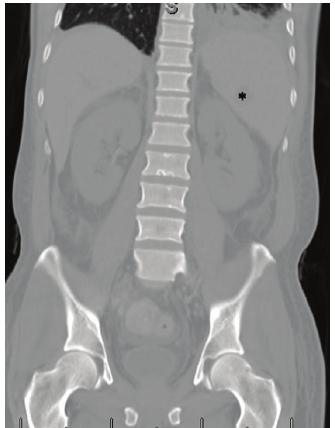
Figure 1: Coronal reconstruction CT in bone window at the time of admission to the outside institution shows essentially normal bone marrow other than some Schmorl’s nodes. Note additional findings of splenomegaly and left basilar consolidation/atelectasis. Focus of hypoattenuation in the spleen ( ∗ ) was interpreted as a focus of splenic infarction. Also note that there is no evidence of osteonecrosis in either